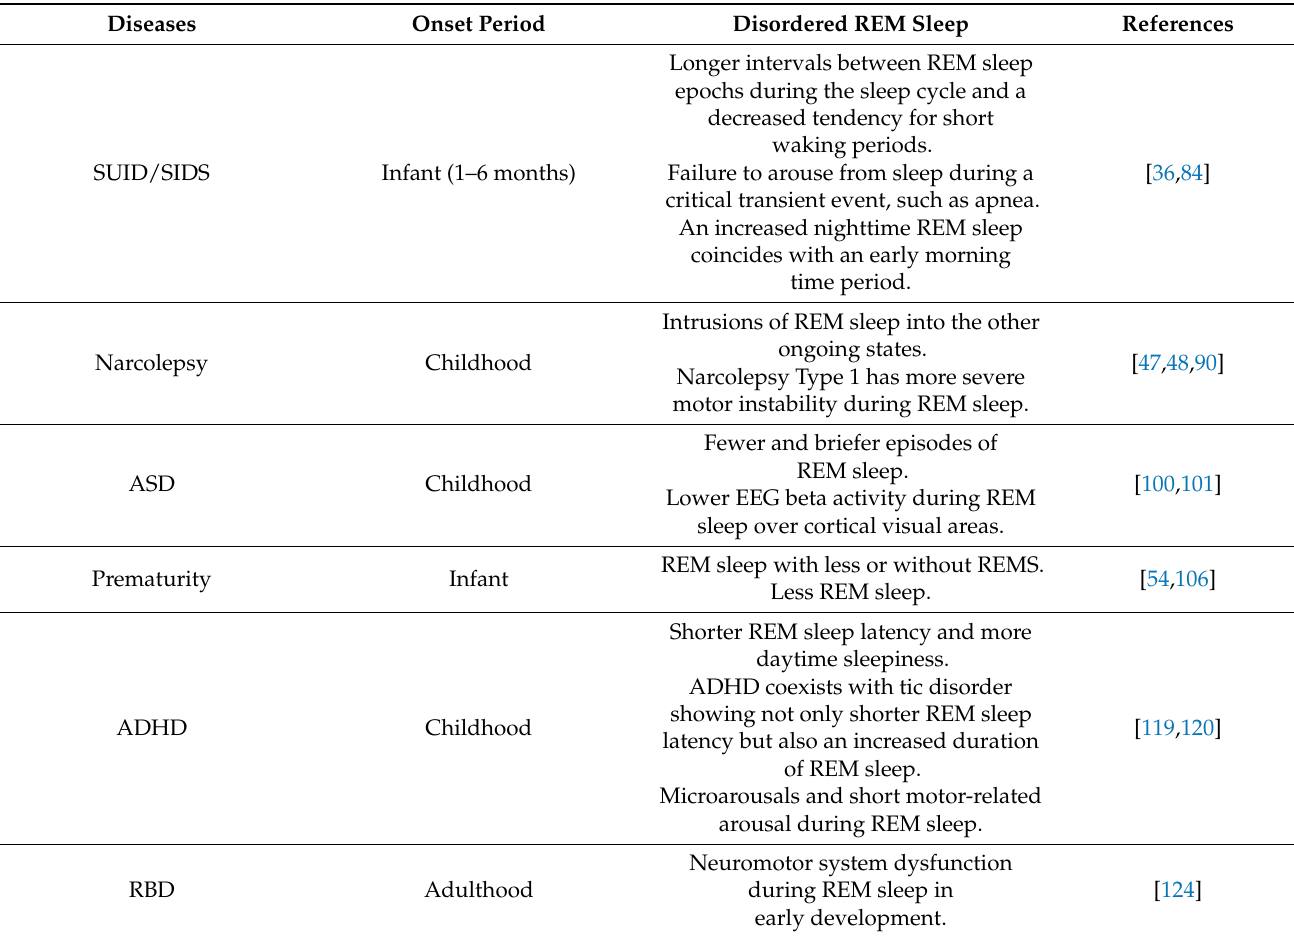
Table 2. Disordered REM sleep features during early development related to neurodevelopmental disorders in